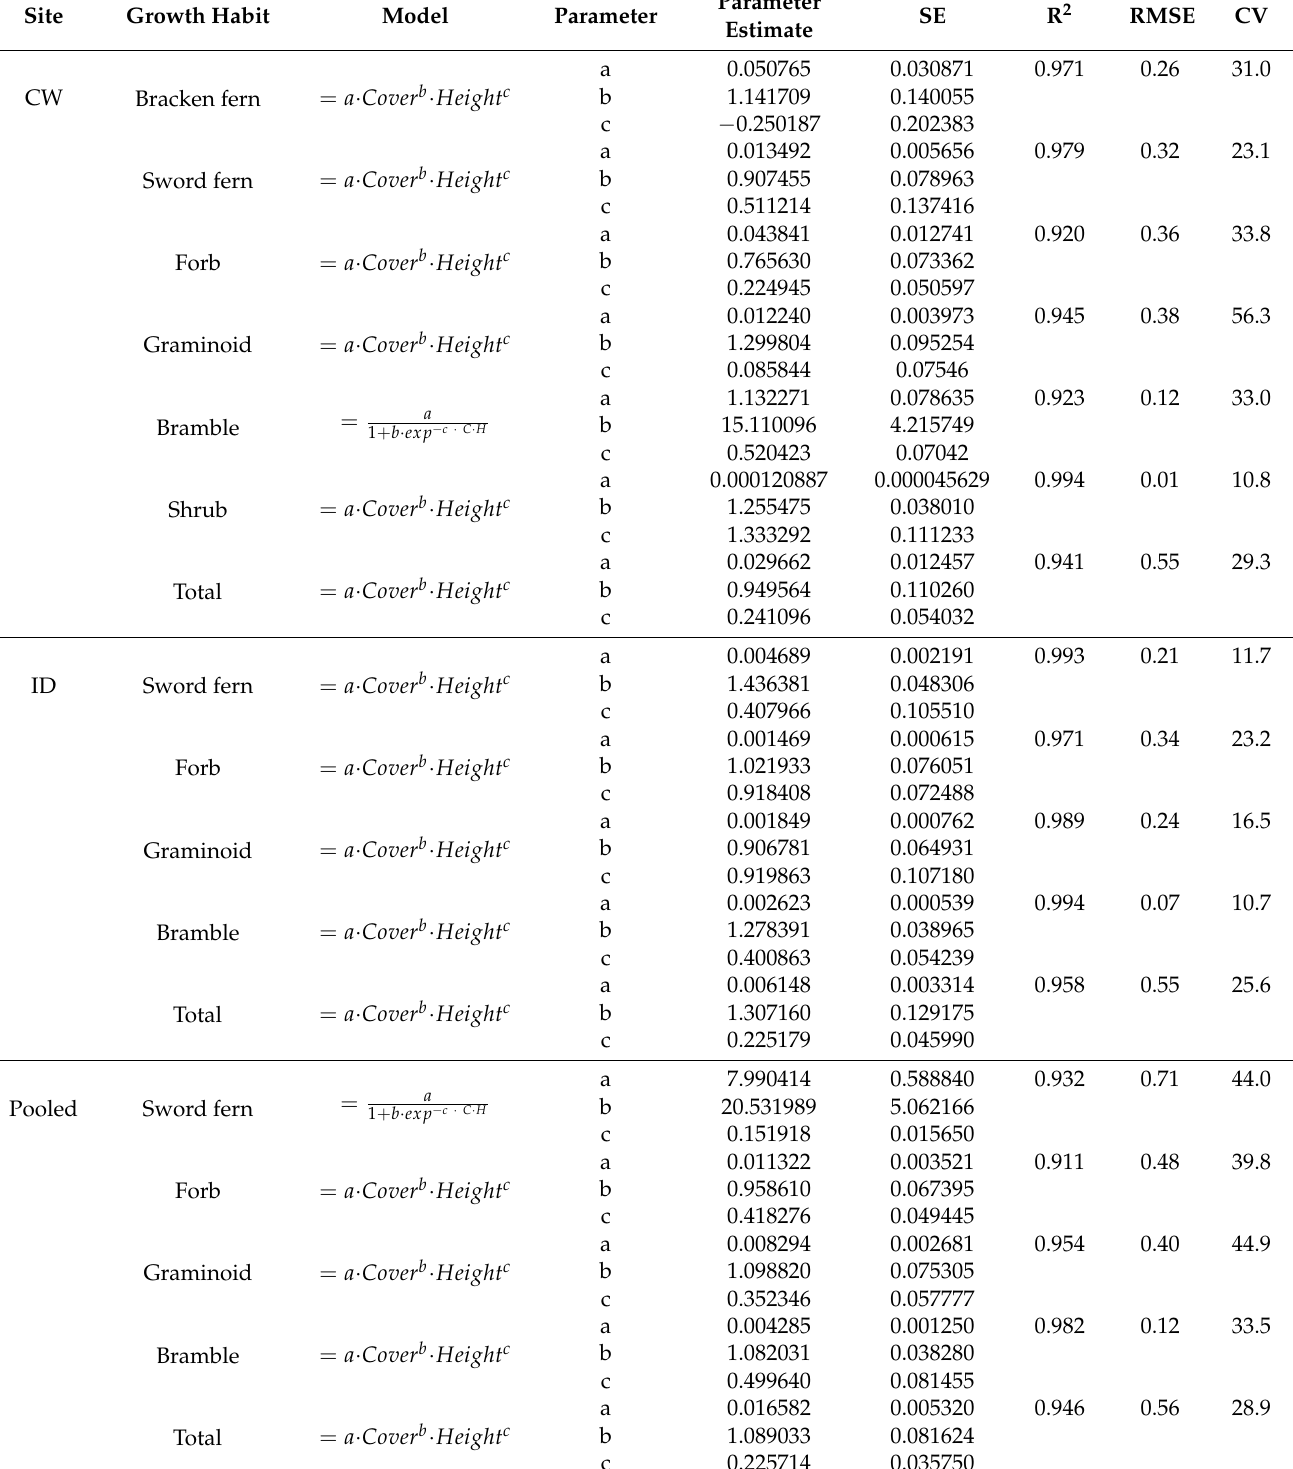
Table 4. Parameter estimates and fit statistics of the selected functions to estimate biomass from cover and height for each growth habit of early-seral vegetation growing in Western